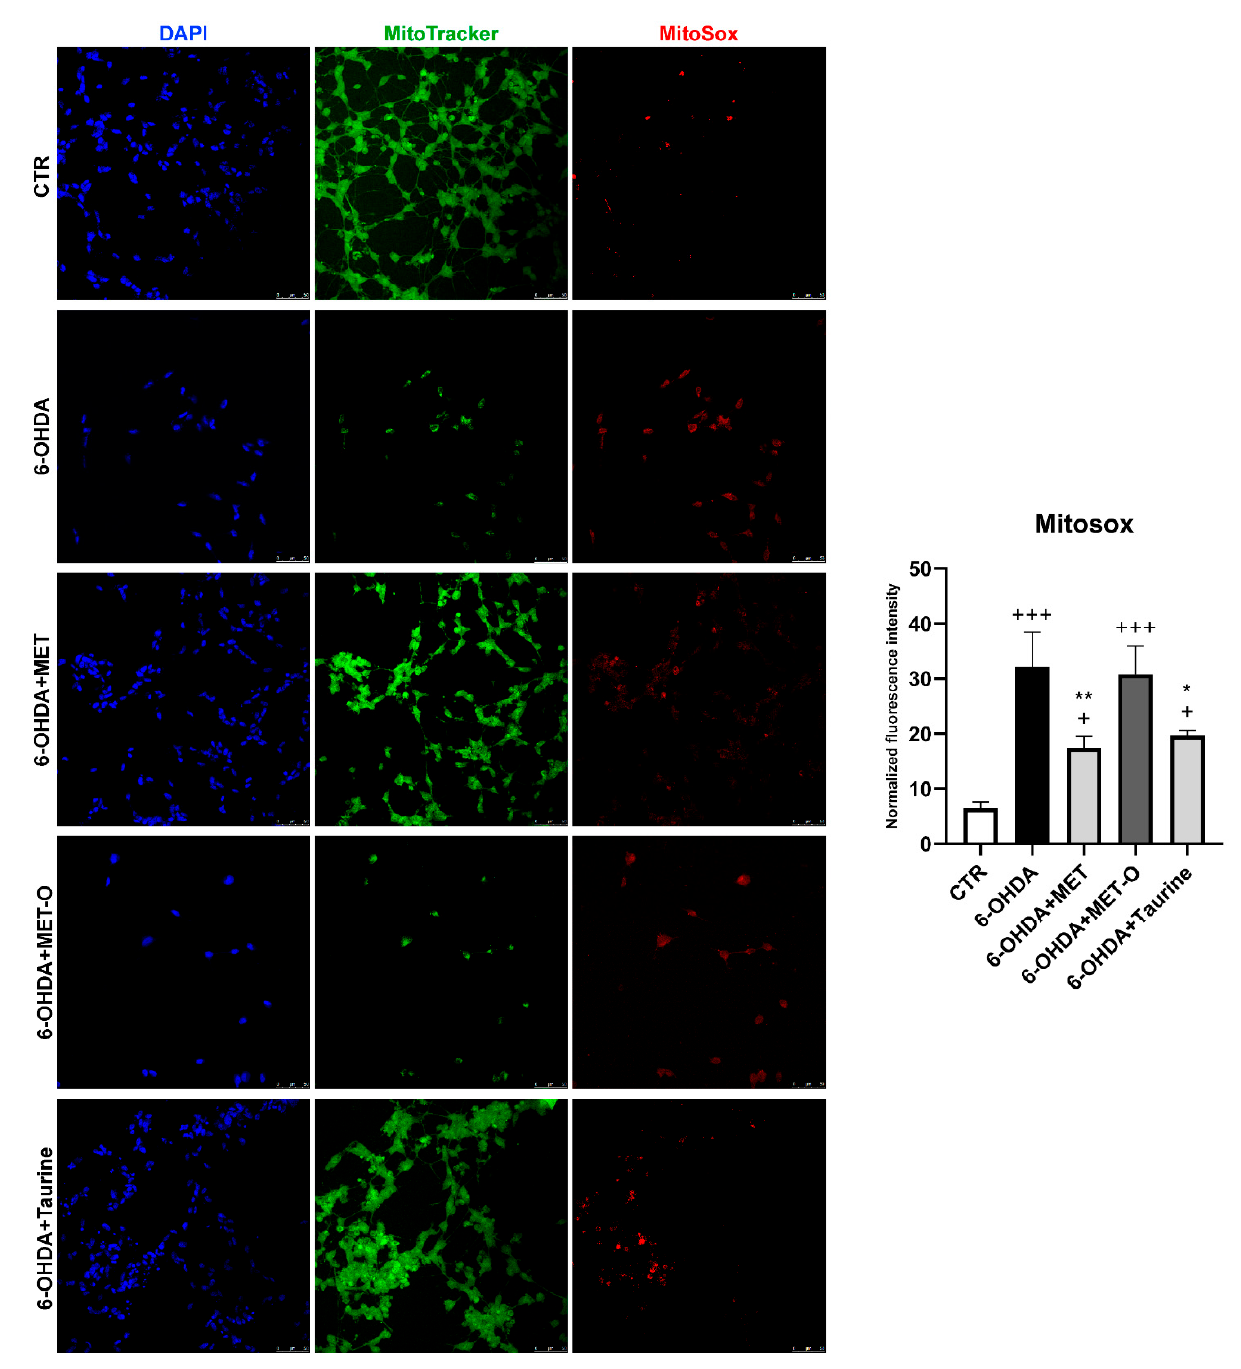
Figure 8. On the left, Mitotracker Green, Mitosox Red, and DAPI representative figures are shown; on the right, the normalized fluorescence intensity graph is shown. Scale bar: 50 µ m. Data are mean ± SD of 3 different experiments. ** p < 0.005, * p < 0.05 vs. 6-OHDA; +++ p < 0.0001, + p < 0.05 vs. CTR.